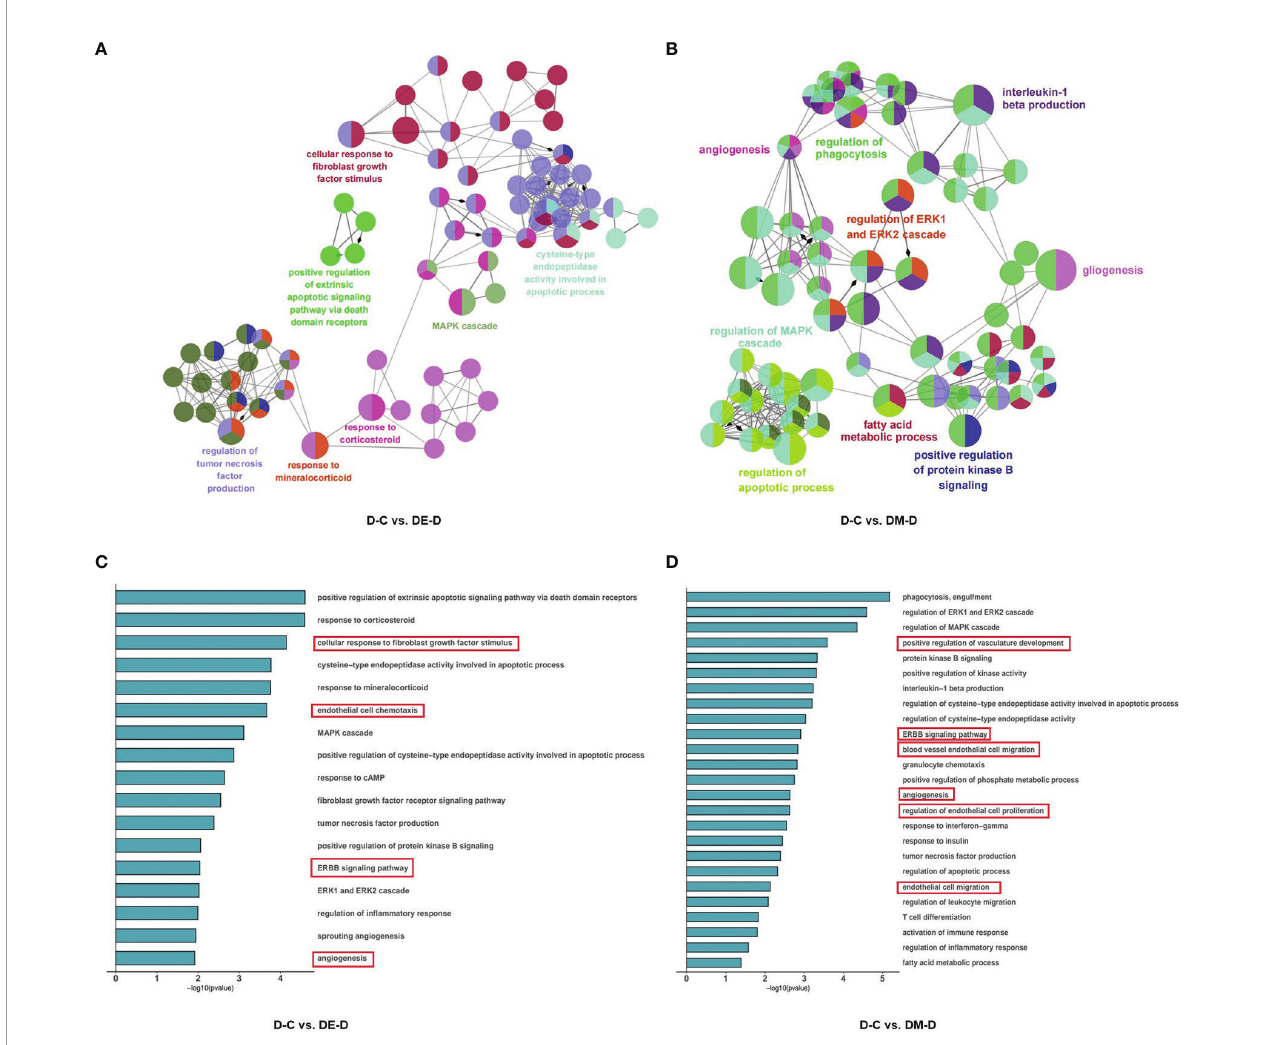
FIGURE 5 | Functional enrichment analysis of DEGs. (A, B) Network based analysis of signi fi cantly enriched GO terms when comparing DE-D vs. D-C and DM-D vs. D-C. (C, D) Histograms with highly enriched GO terms related to myocardium. A red border indicates terms related to endothelial cell and angiogenesis. C (control), D (diabetic), DE (diabetic+ exercise), DM (diabetic +